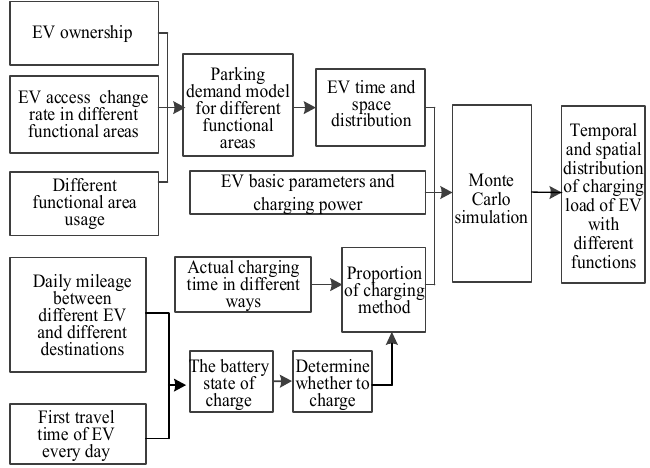
Figure 1. Time and space distribution prediction of the charging load of electric vehicle (EV).